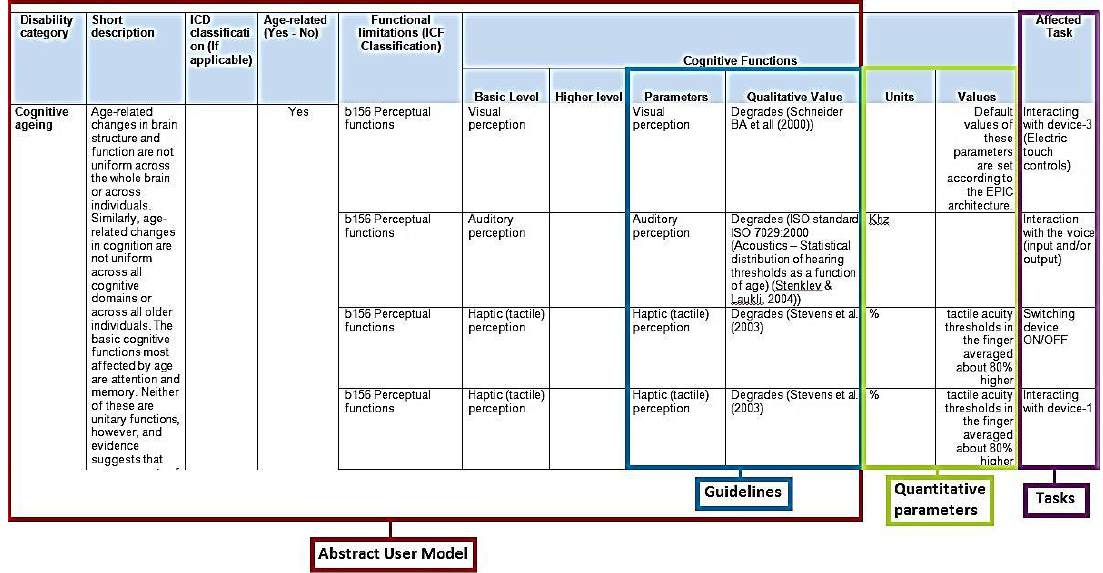
Figure 6. Structure of the Generic Cognitive Virtual User Model. Notes: Schneider et al. [44], Stevens et al. [45], Stenklev and Laukli [46].